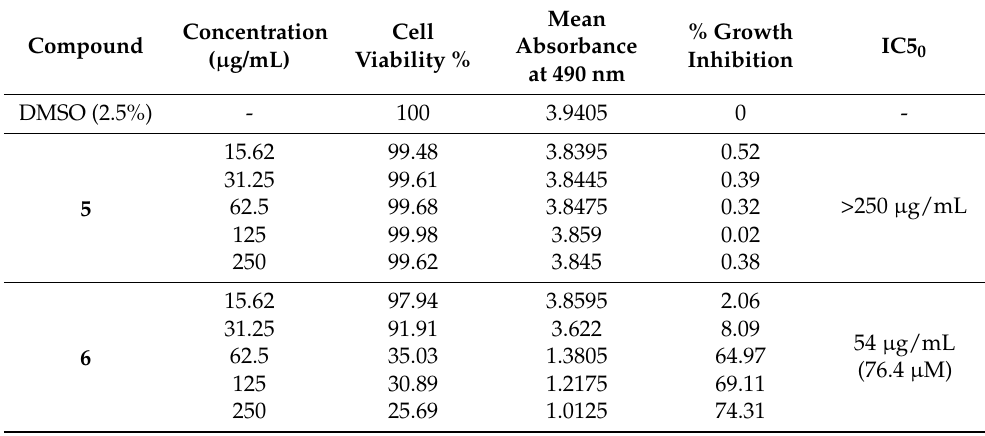
Table 2. Determination of IC 50 ( µ M/mL) from the cell viability observed after administration of different concentrations of compound 6 on HeLa cancer cell line.